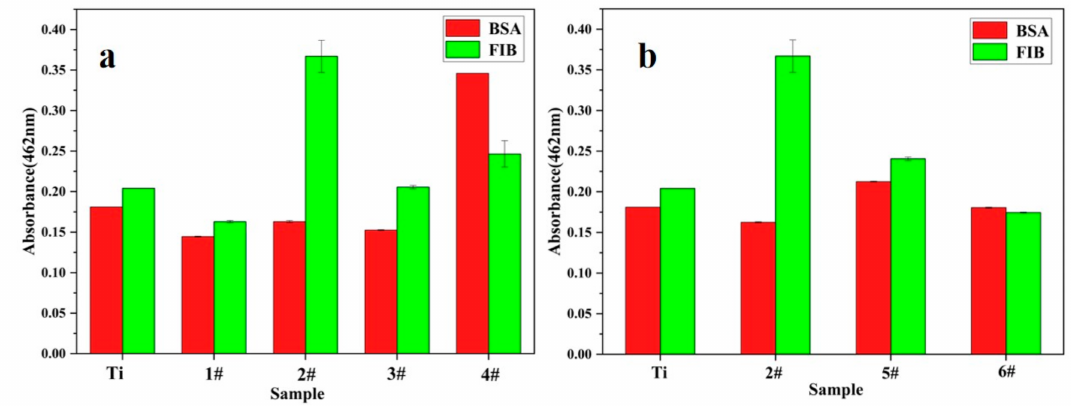
Figure 7. Surface fibrinogen and albumin adsorption capacity on various surfaces (indicated by OD value). ( a ) Different bias voltage, ( b ) different copper